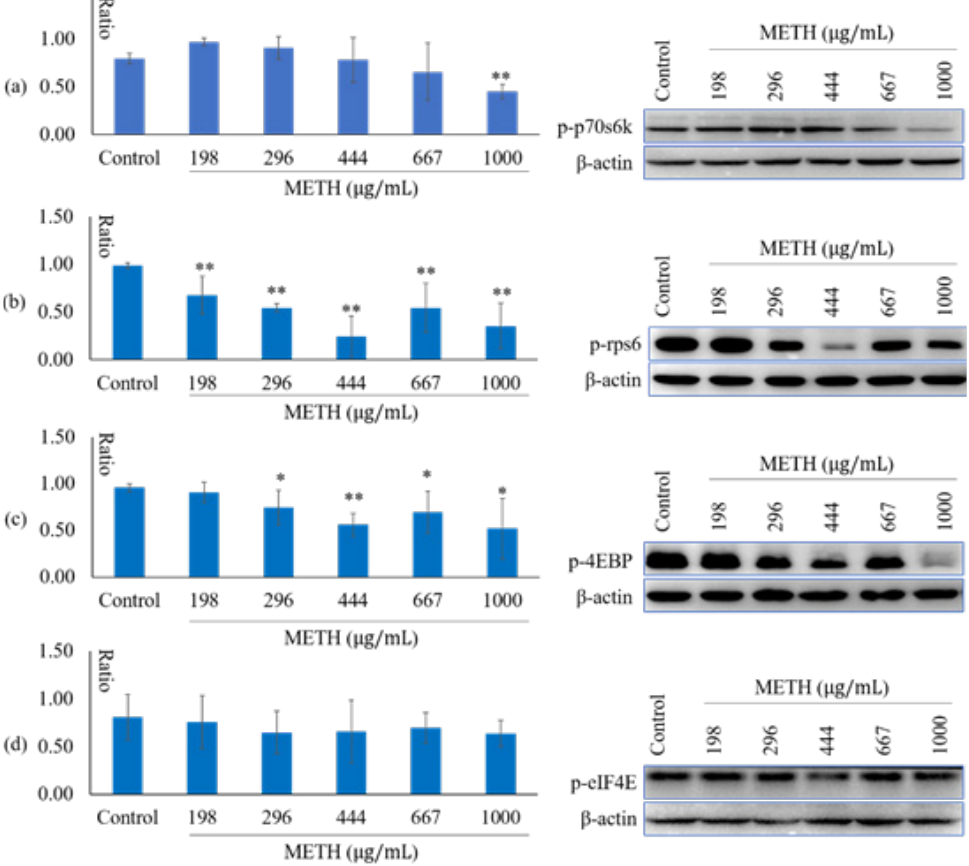
Figure 6: METH inhibited phosphorylation of downstream kinases of mTORC1. (a) the expression of p-p70s6k; (b) the expression of p-rps6; (3) the expression of p-4EBP; (3) the expression of p-eIF4E. The annotation * indicates a p value < 0.05 versus control group. The annotation ** indicates a p value < 0.01 versus control